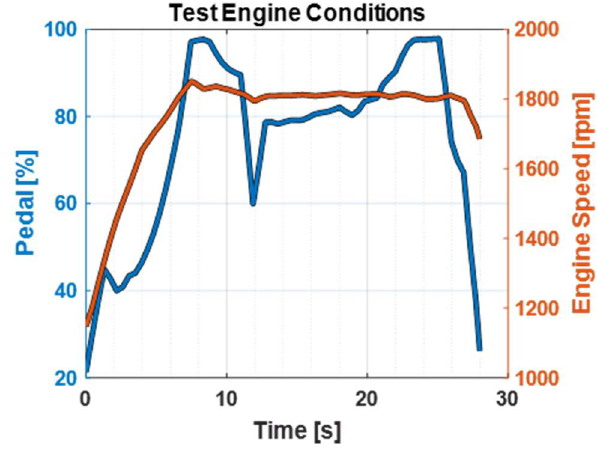
Figure 18 . Test engine conditions with on left axis the pedal, and on the right axis the engine speed.